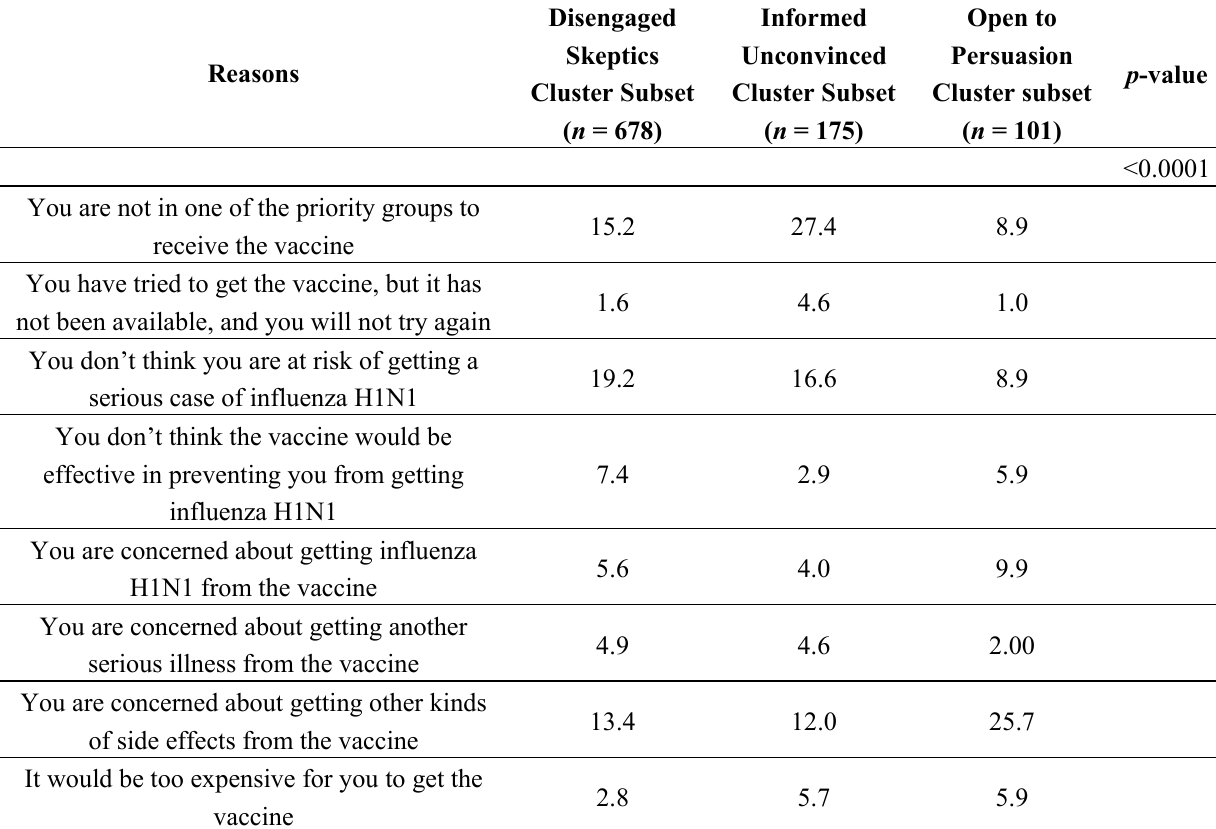
Table 3. Distribution (%) of main reason for responding they “will not or do not know” if they will get the H1N1 vaccine ( n =